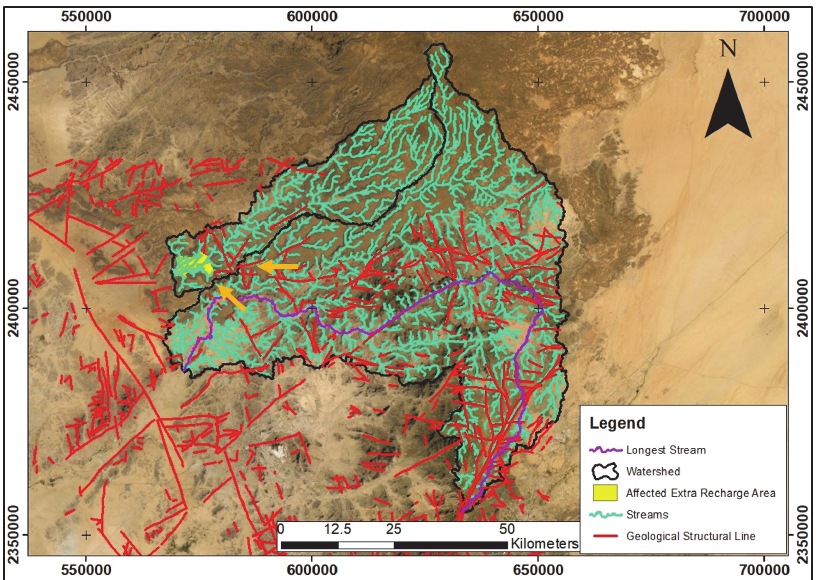
Figure 22. Geological fractures in the study area overlayed with the streams Al ‐ Lusub watershed